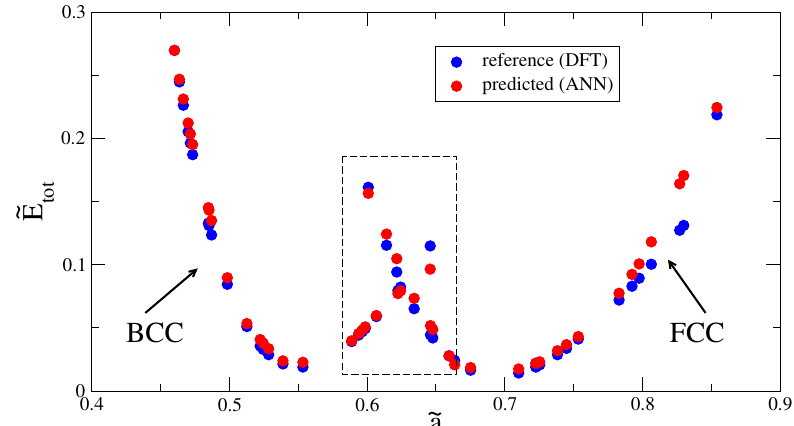
Figure 6. Rescaled total energy vs. lattice constant for a pre-set composition, with 32 atoms in the supercell, Co(7)-Cr(7)-Fe(7)-Ni(7)-Al(4), and random choice of the lattice constant and structural configuration (FCC and BCC). The region enclosed by the dashed lines marks the crossing of the FCC and BCC